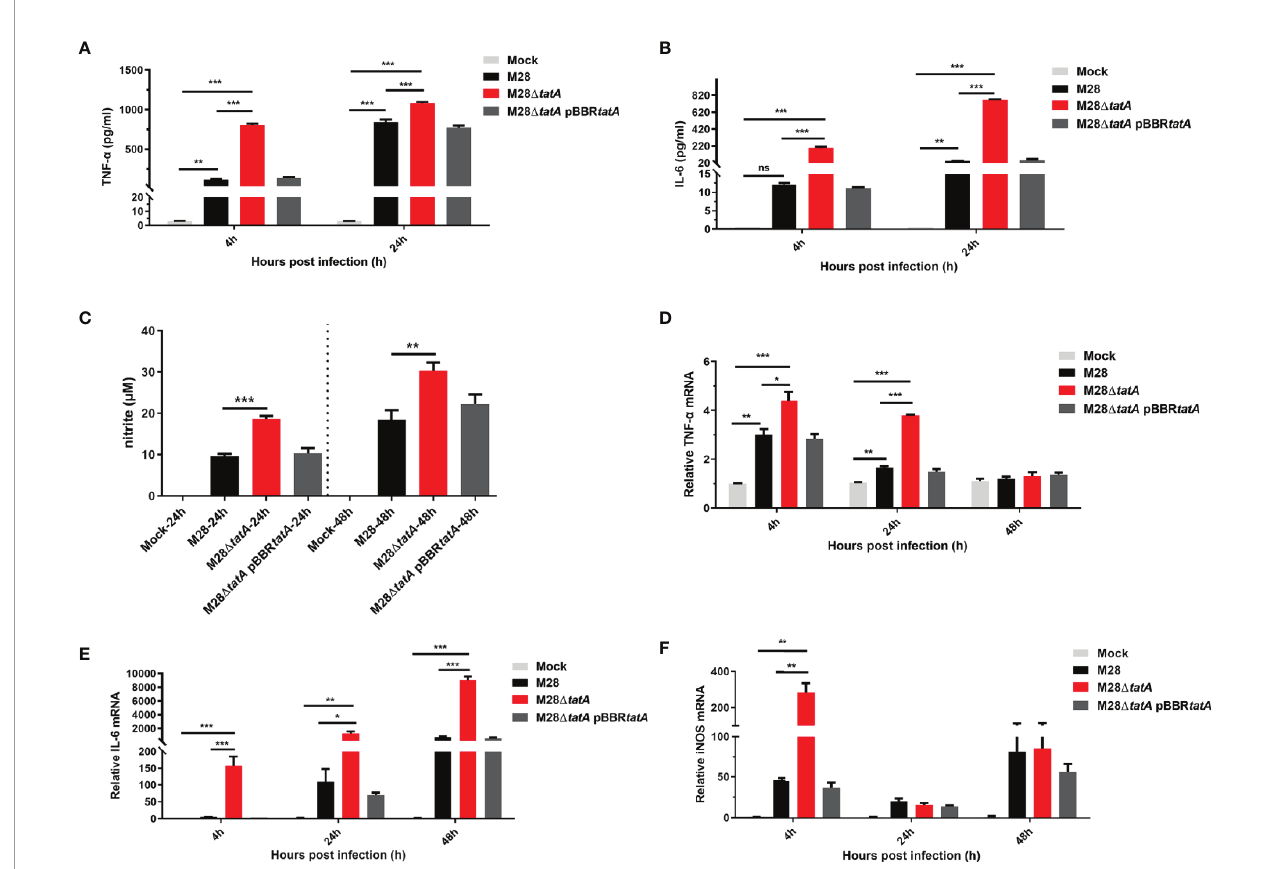
FIGURE 5 | Expression and production of nitric oxide (NO) and in fl ammatory cytokines in RAW264.7 cells after infection with M28, M28 D tatA , and M28 D tatA pBBR tatA . The production of TNF- a (A) and IL-6 (B) in RAW264.7 cells after infection with the indicated strain was determined by ELISA. The production of NO (C) in RAW264.7 cells after infection with the indicated strains was determined by Griess assays. The relative transcription levels of TNF- a (D) , IL-6 (E) and iNOS (F) in RAW264.7 cells after infection with the indicated strain were determined by qRT-PCR. The SD is indicated by the error bar. *p < 0.05; **p < 0.01; ***p < 0.001; ns, not signi fi